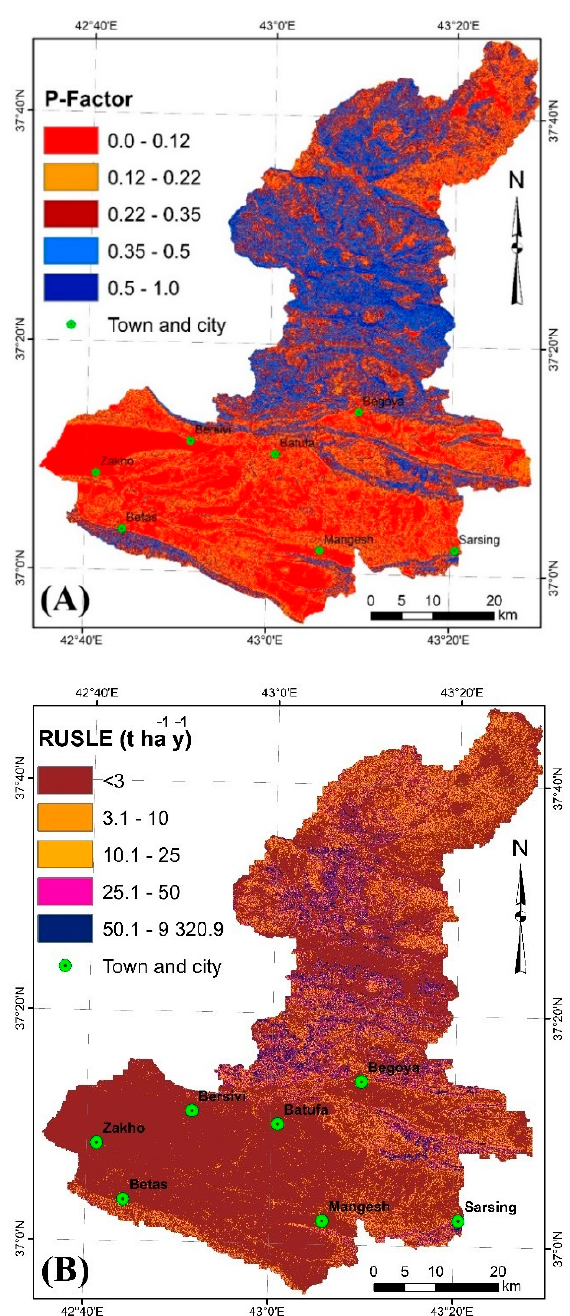
Figure 8. Maps showing distribution of the: ( A ) P factor, and ( B ) soil loss (t.ha − 1 .y − 1 ) in the KhRB.